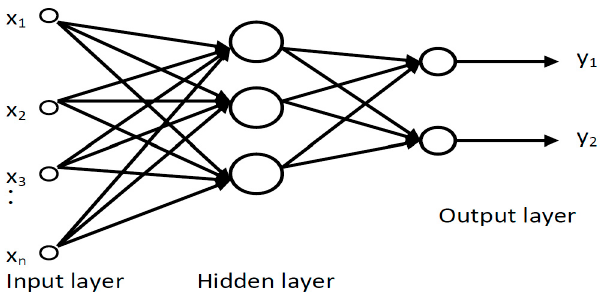
Figure 10. Neural network architecture used to classify network traffic flow signals (two-layer neuronal network).